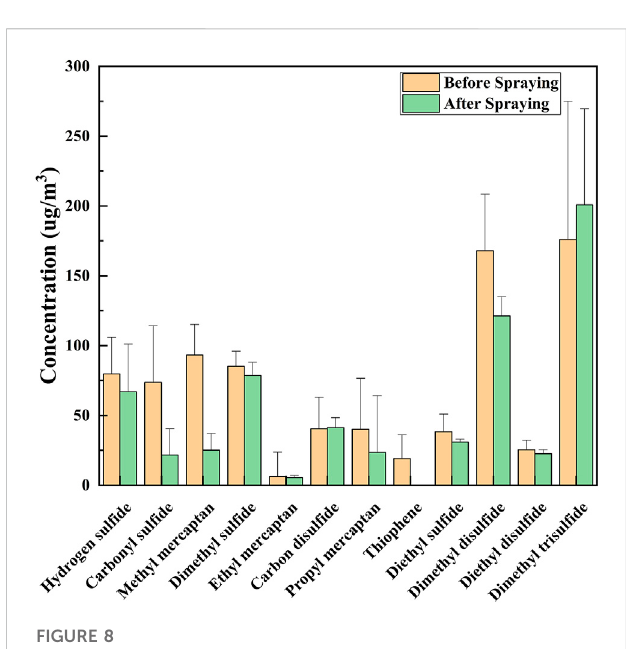
FIGURE 8 Changes in sulfur compounds before and after spraying.